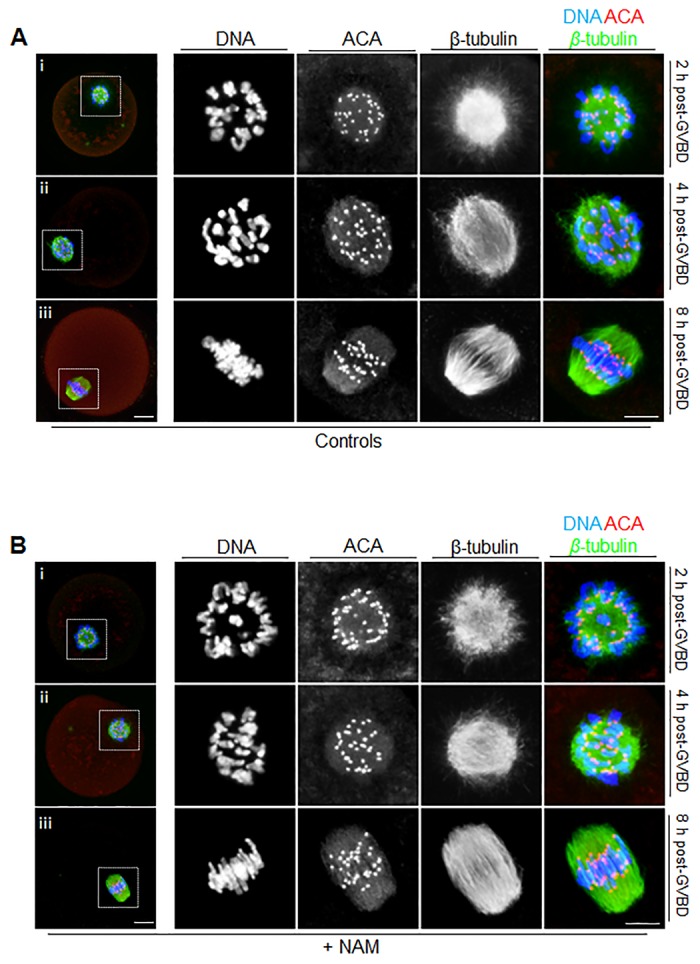
Spindle assembly and chromosome alignment during meiosis I.Immunofluorescence staining of oocytes for chromosomes (DNA), kinetochores (labelled using anti-centromere antibody; ACA) and spindle microtubules (β-tubulin) at 2 h, 4 h and 8 h post-GVBD, representing ball, intermediate and bipolar stages, respectively, in controls (A), and NAM-treated (B) oocytes. Panels to the extreme left are whole-oocyte images whilst panels to the right are magnified images of the regions enclosed by the dashed white squares. Scale bars = 10 μm.